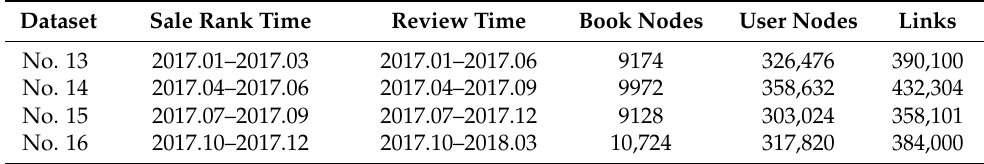
Table 3. Dataset-related information in